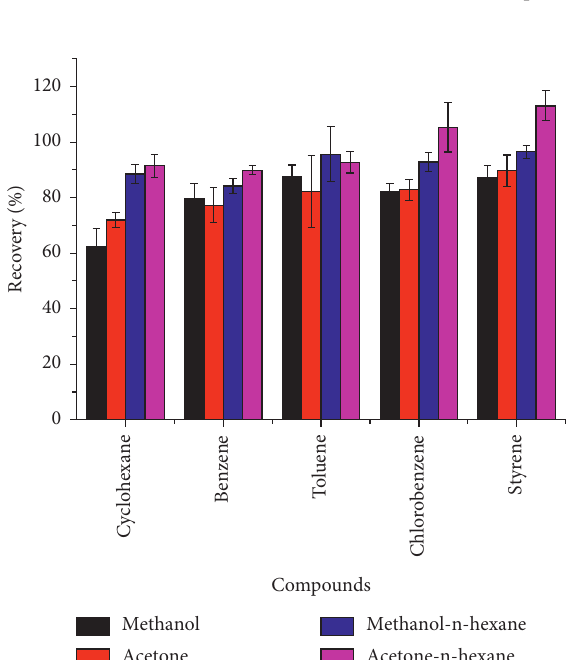
Figure 2: The procedure of sample preparation.